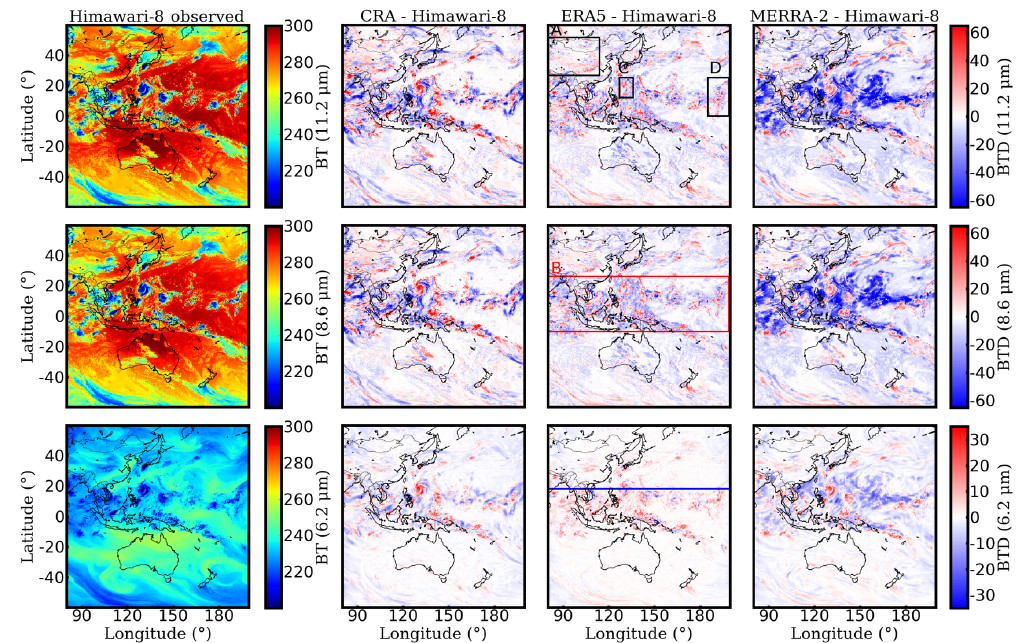
Figure 3. Observed results and the brightness temperature differences between the observations and simulations in the 11.2µm (top), 8.6µm (middle), and 6.2µm (bottom) channels. The results are taken at the same time as that in Fig. 1.